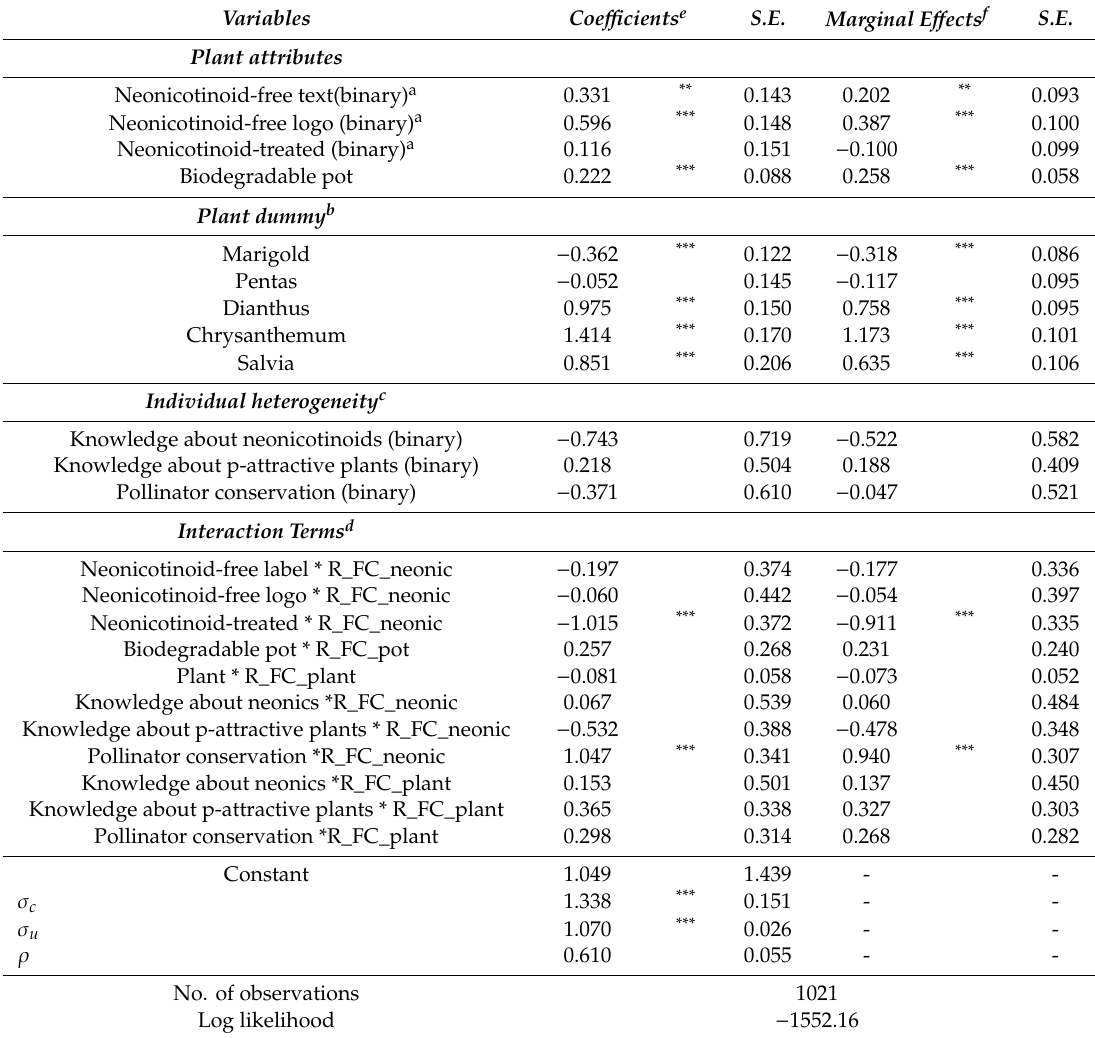
Table 5. E ff ects of attribute focus (measured by relative total fixation counts) on bid value: random e ff ects tobit